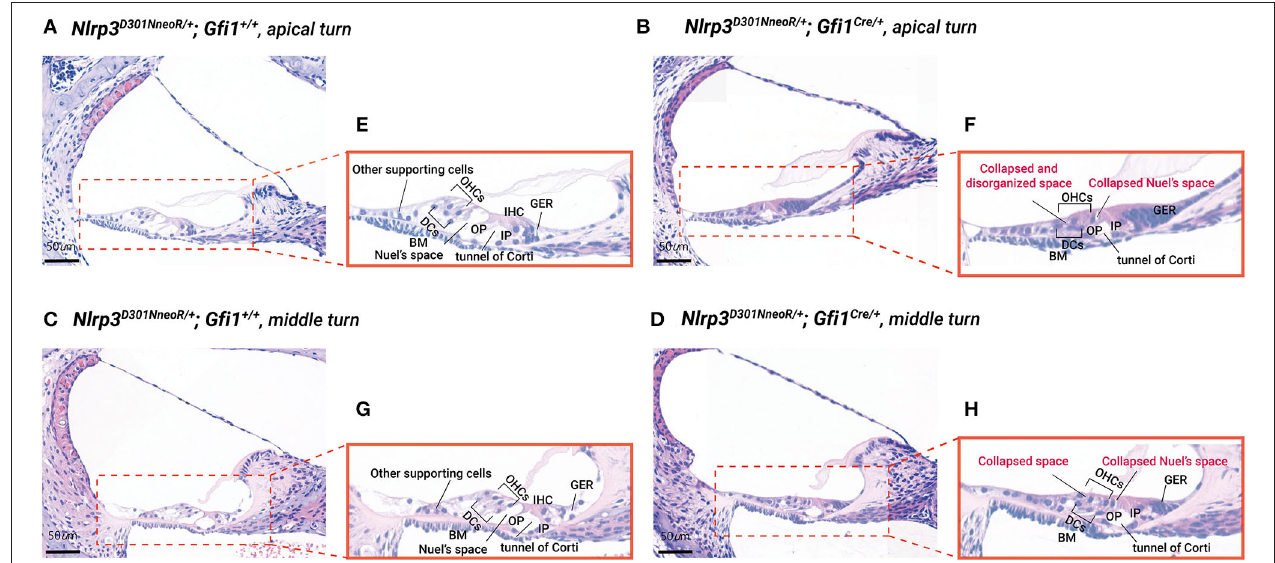
FIGURE 5 | Cochlear morphology of Nlrp3 D 301 NneoR / + ; Gfi1 Cre / + and Nlrp3 D 301 NneoR / + ; Gfi1 + / + (normal phenotype) mice at P12. Representative hematoxylin and eosin-stained paraffin sections of Nlrp3 D 301 NneoR / + ; Gfi1 + / + mouse [ (A) , apex/ (C) , middle] and Nlrp3 D 301 NneoR / + ; Gfi1 Cre / + mice [ (B) , apex/ (D) , middle]. Close-ups of the organ of Corti (dotted box) from Nlrp3 D 301 NneoR / + ; Gfi1 + / + mice (E,G) and Nlrp3 D 301 NneoR / + ; Gfi1 Cre / + mice (F,H) are illustrated. Notice the apparent collapse of organ of Corti in Nlrp3 D 301 N / + mice (P12). P12, postnatal day 12; OHCs, outer hair cells; IHCs, inner hair cells; DCs, Dieter’s cells; BM, basilar membrane; OP, outer pillar cells; IP, inner pillar cells; GER, greater epithelial ridge. The scale bars represent